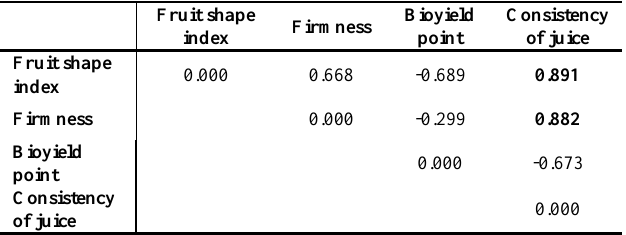
Table 3. Relationship between fruit parameters and juice